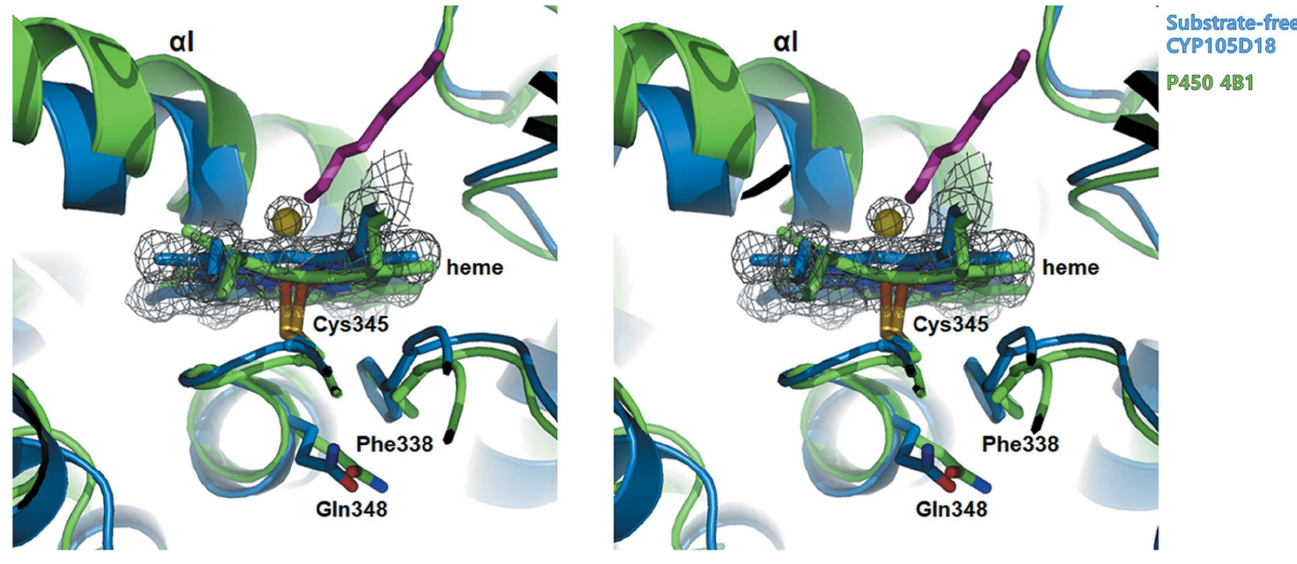
Figure 6 Superposition of CYP105D18 with H 2 O 2 -insensitive rabbit P450 4B1. Residues corresponding to Cys448, Phe441 and Gln451 of P450 4B1 are shown using sticks. The 2 F o (cid:2) F c electron density map for the heme and water molecule for CYP105D18 is shown as a gray mesh (contoured at the 2.0 (cid:7) level). The octane molecule from P450 4B1 is presented as a purple